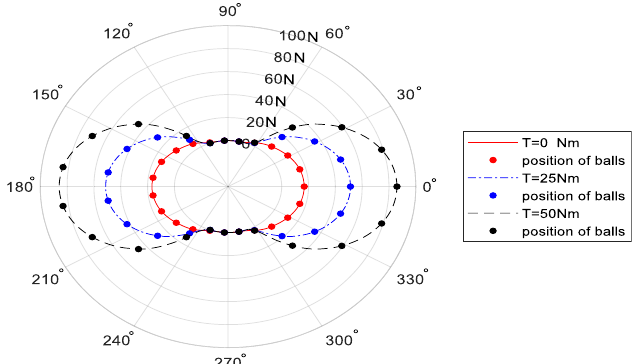
Fig. 10. Relationship of ball load and angular position under